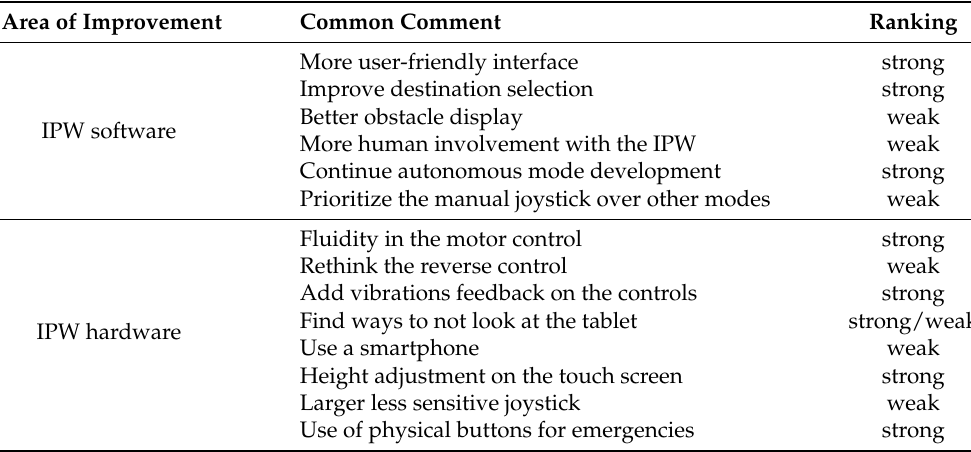
Table 6. Common areas of improvements along with the common improvement and the allocated ranking score. Area of Improvement Common Comment Ranking More user-friendly interface strong Improve destination selection strong Better obstacle display weak IPW software More human involvement with the IPW weak Continue autonomous mode development strong Prioritize the manual joystick over other modes weak Fluidity in the motor control strong Rethink the reverse control weak Add vibrations feedback on the controls strong Find ways to not look at the tablet strong/weak IPW hardware Use a smartphone weak Height adjustment on the touch screen strong Larger less sensitive joystick